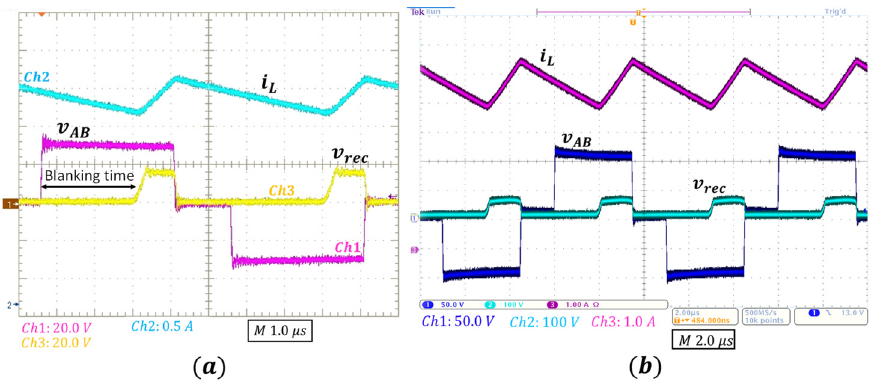
Figure 17. Main waveforms of the experimental prototype at different power levels: ( a ) 8.5 W, ( b ) 70 W.